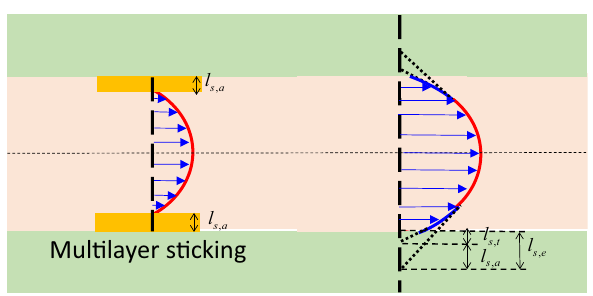
Fig. 1 Effective slip length ( l s , e ) versus wall wettability (Wu et